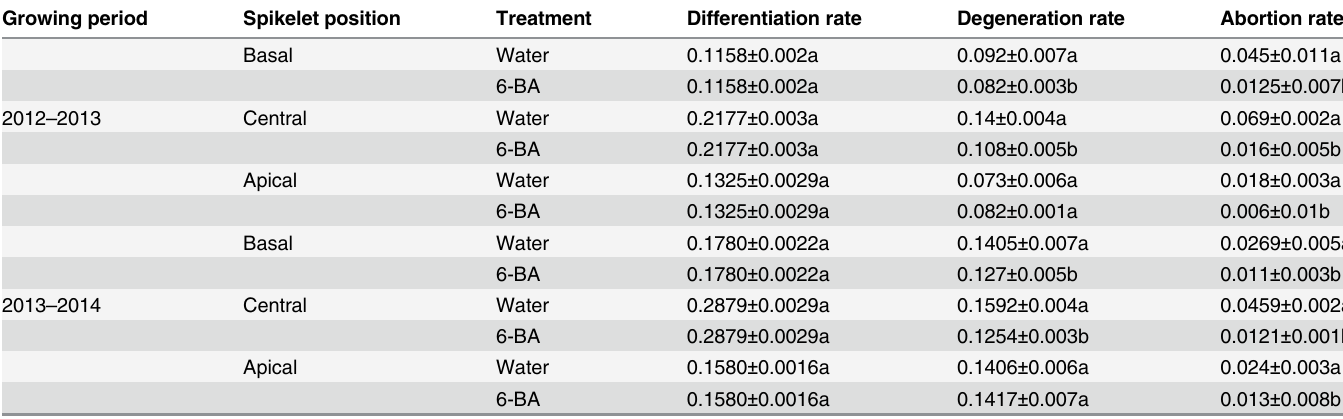
Table 2. Developmental rates of floret primordia for the two treatments at different spikelet positions over the two growth periods. Growing